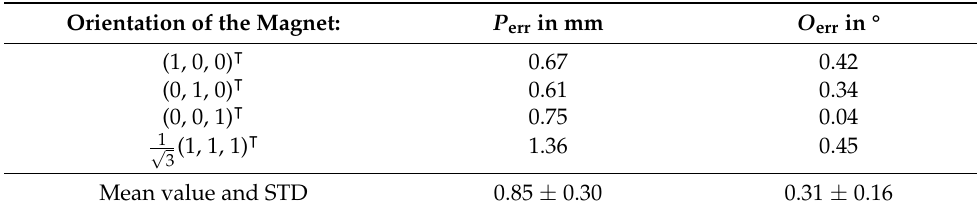
Table 3. Position and orientation errors for a 500 nT